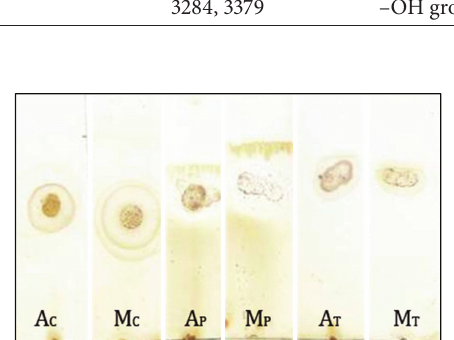
Figure 1: Thin layer chromatogram of Abelmoschus esculentus